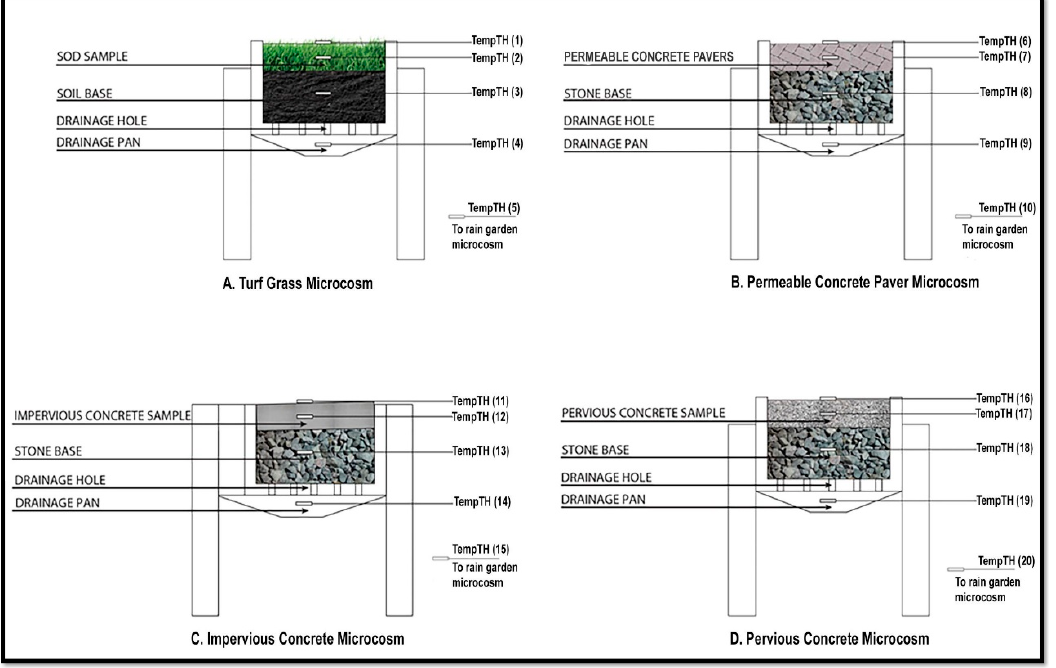
Figure 3. Surface microcosm sections showing subgrade material and thermistors [54].